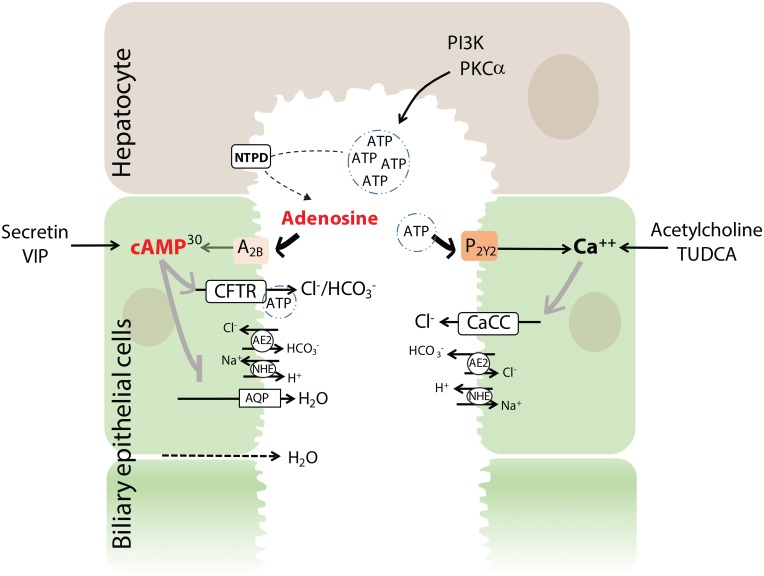
Role of ATP, adenosine, and cAMP in mediating chloride, bicarbonate, and water secretion by the biliary epithelium.Biliary canalicular secretion of ATP stimulates purinergic receptors (P2Y2) and calcium signaling which stimulates calcium-activated chloride secretory channels (CaCC). Hydrolysis of ATP by nucleoside triphosphate diphosphorohydrolase (NTDP) to adenosine stimulates nucleoside-selective receptors (A2B) and cAMP signaling which stimulates CFTR-mediated chloride secretion. Water is secondarily translocated into bile via transcellular (aquaporin channels; AQP) and paracellular pathways. Exogenous endocrine, paracrine and neurocrine stimuli of cAMP and calcium are also shown. Compounds in red font were decreased in dogs with gallbladder mucocele formation in comparison to control dogs. Superscript numbers, when present, indicate rank of the compound as identified by Random Forest analysis as able to distinguish between control dogs and dogs with gallbladder mucocele formation. Basolateral transport mechanisms are not illustrated. VIP, vasoactive intestinal polypeptide; TUDCA, tauroursodeoxycholic acid.